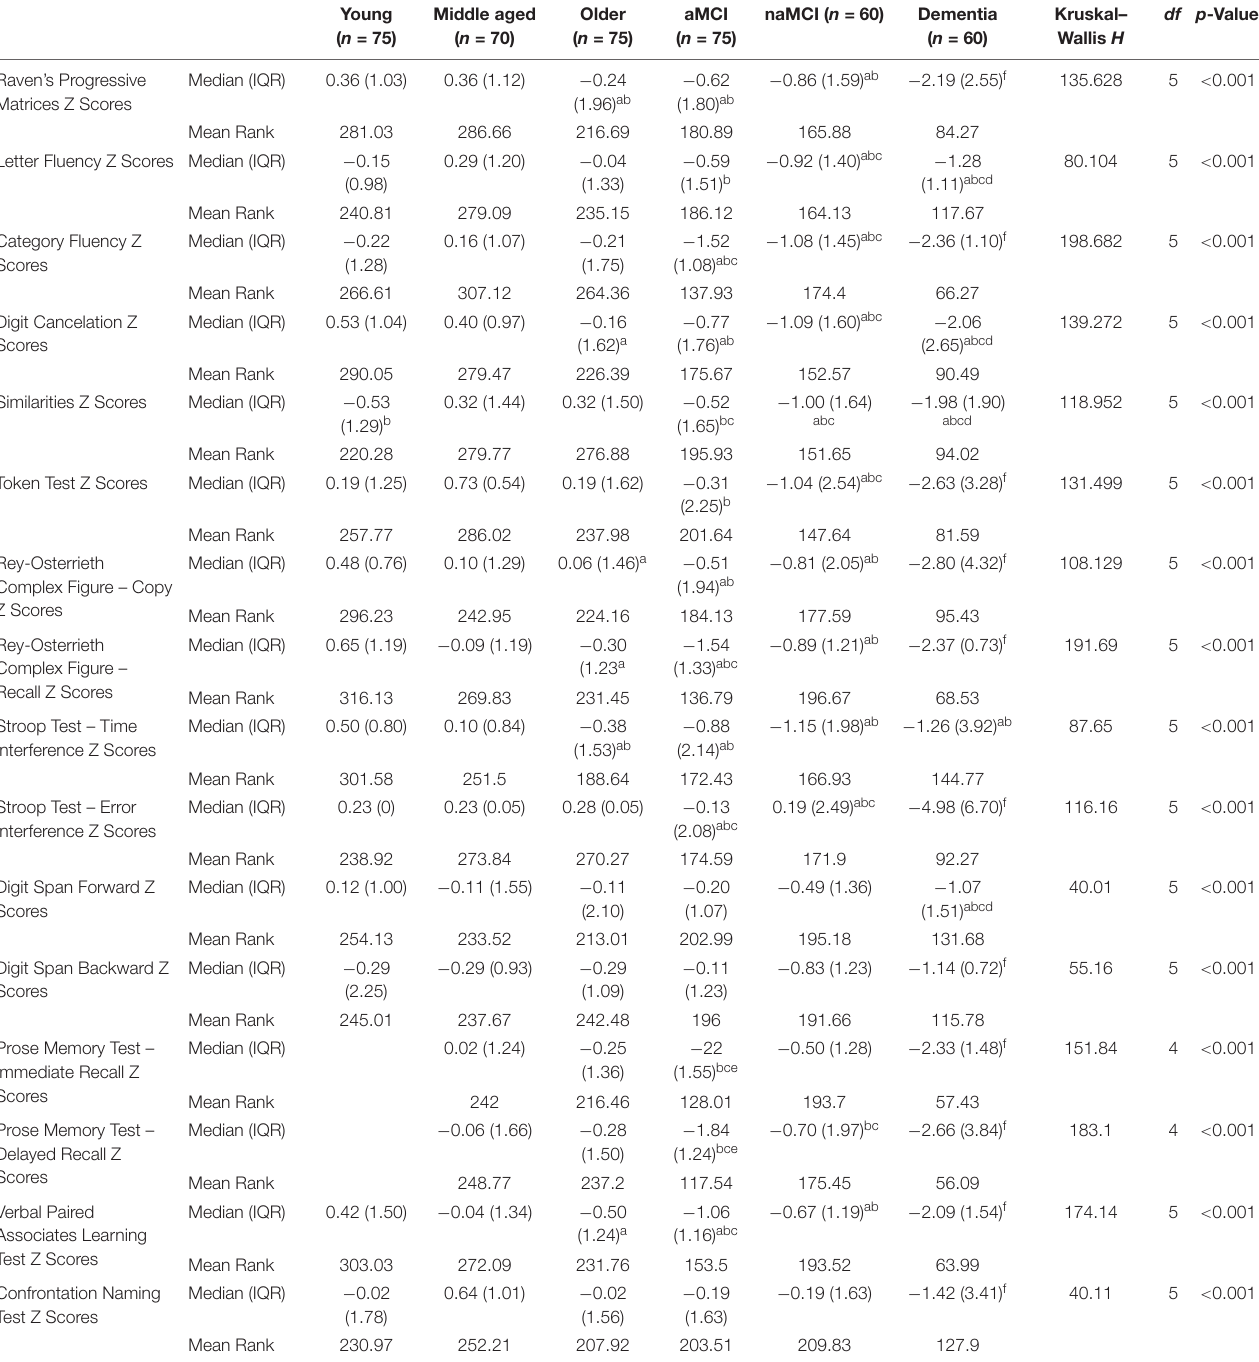
TABLE 2 | Median (and interquartile range) of cognitive test z -scores for each participant group, with results of a Kruskal–Wallis H